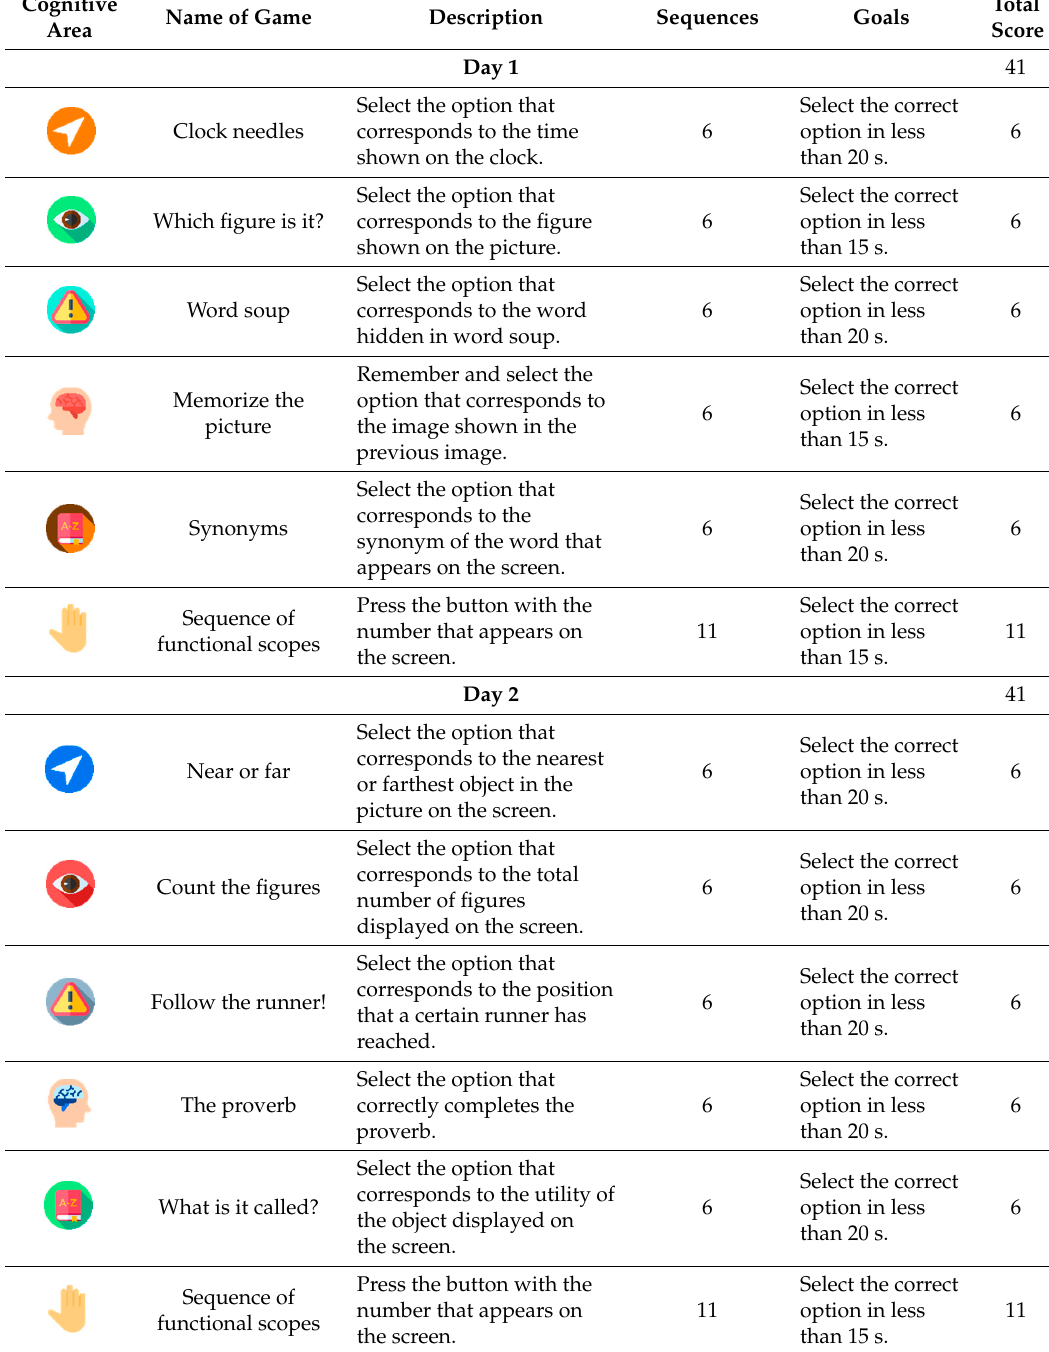
Table 2. Content of the training sessions.